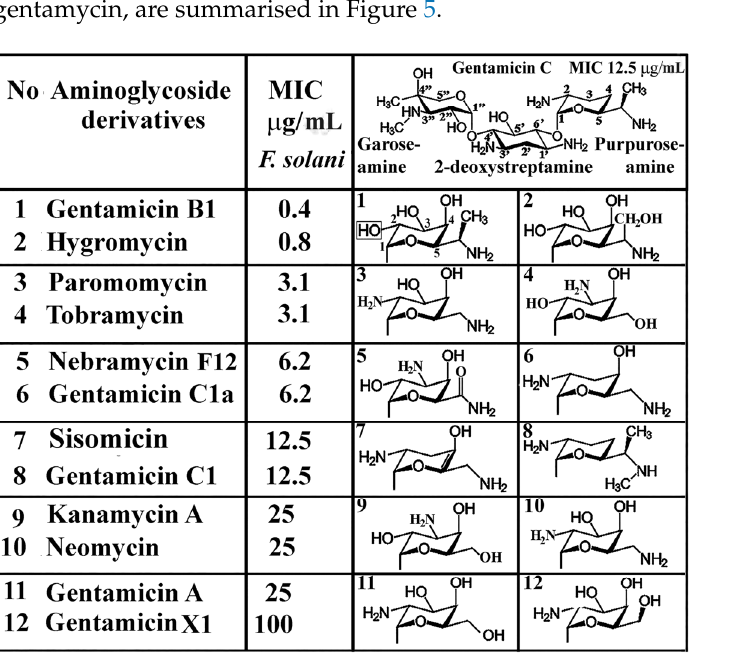
Figure 5. Antifungal activity of aminoglycosides on Fusarium solani. The ring structure of gentamicin C consists of garoseamine, 2-deoxystreptamine, and purpuroseamine. The substituents of purpuroseamine derivatives are given for aminoglycosides that are numbered (1–12). In the figure, only the structure of the aminoglycosides that consist of 3 rings are given. Modified with permission of [26].